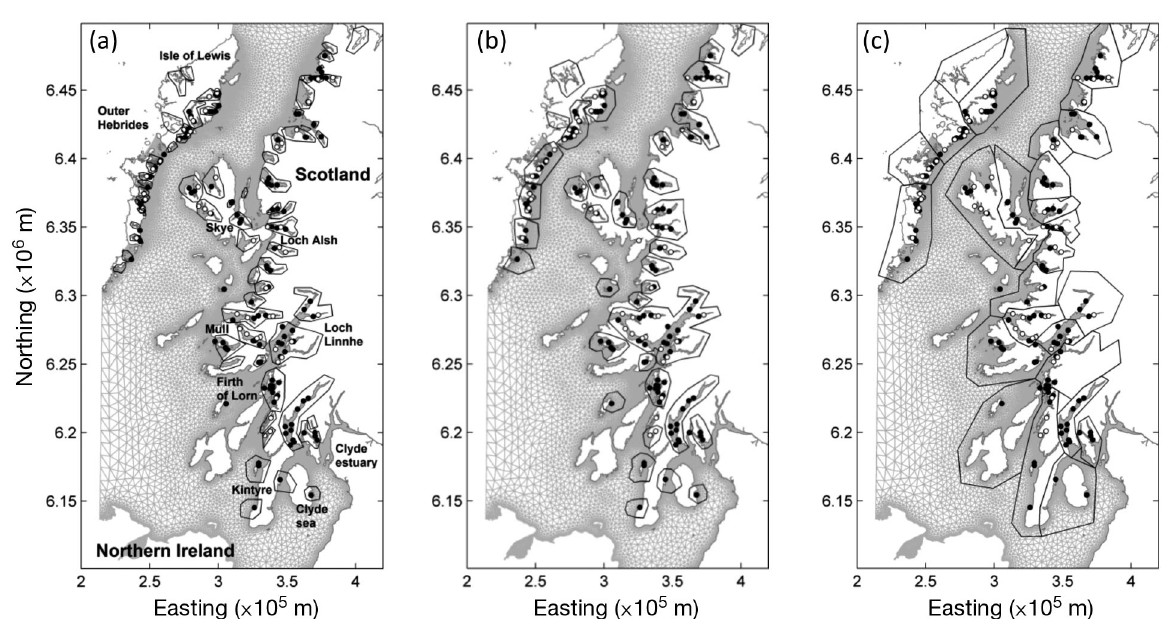
Fig. 1. Management units in operation for salmon aquaculture in Scotland, superimposed over the hydrodynamic model mesh. (a) Industry-defined Farm Management Areas (FMAs). (b) Marine Scotland Disease Management Areas (DMAs). (c) Scottish Salmon Producers Organisation Fish Health Management Reporting Areas (FHMRAs). Small discs indicate active (black) and inactive (white) seawater salmon aquaculture site locations. Presented analyses are based upon networks of the active sites. Only sites within the hydrodynamic model domain are